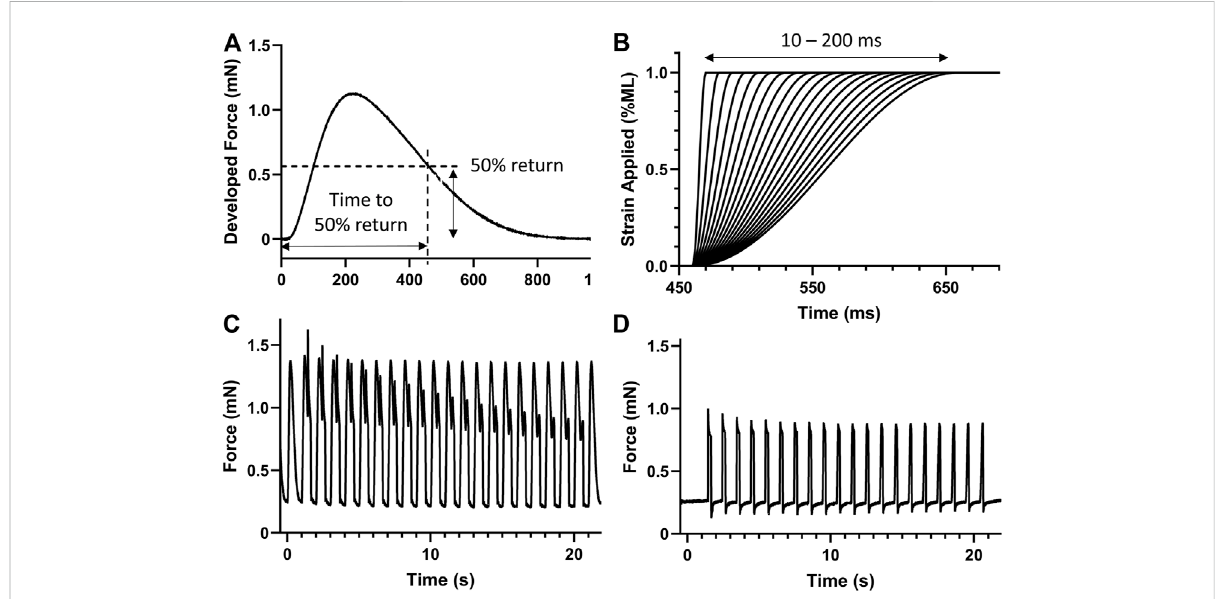
FIGURE 2 Stretch protocol. (A) The time to 50% return was noted for the isometric force transient. (B) A series of 20 stretches from 10 to 200 ms in durationweregeneratedtoapplya1%strainonthemuscleatthetimeof50%return,i.e.,461 msinthiscase. (C) Examplestretchprotocolappliedto stimulated isometric force transients. (D) The same stretch protocol was also applied without stimulation to record the expected force response of passive components. n = 8 rat papillary